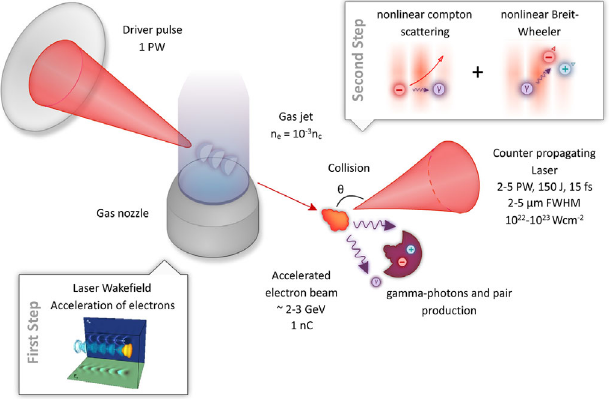
ffiffiffiffiffiffiffiffiffiffiffiffiffiffiffiffi p p 2 þ p 2 Þ , x z